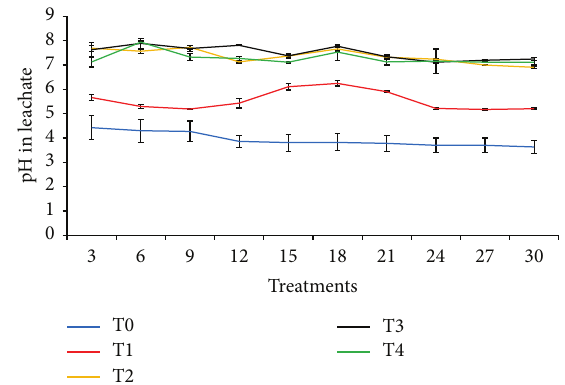
Figure 10: pH in leachate at three-day interval over 30 days of leaching experiment. Note . T0: 64 g soil (no urea); T1: 64g soil + 7.40 g urea (no additives); T2: 64 g soil + 7.40 g urea + 6 g clinoptilolite zeolite; T3: 64 g soil + 7.40g urea + 1.54 g compost; T4: 64 g soil + 7.40g urea + 1.54 g compost + 6 g clinoptilolite zeolite. Note . Bar represents standard error of the